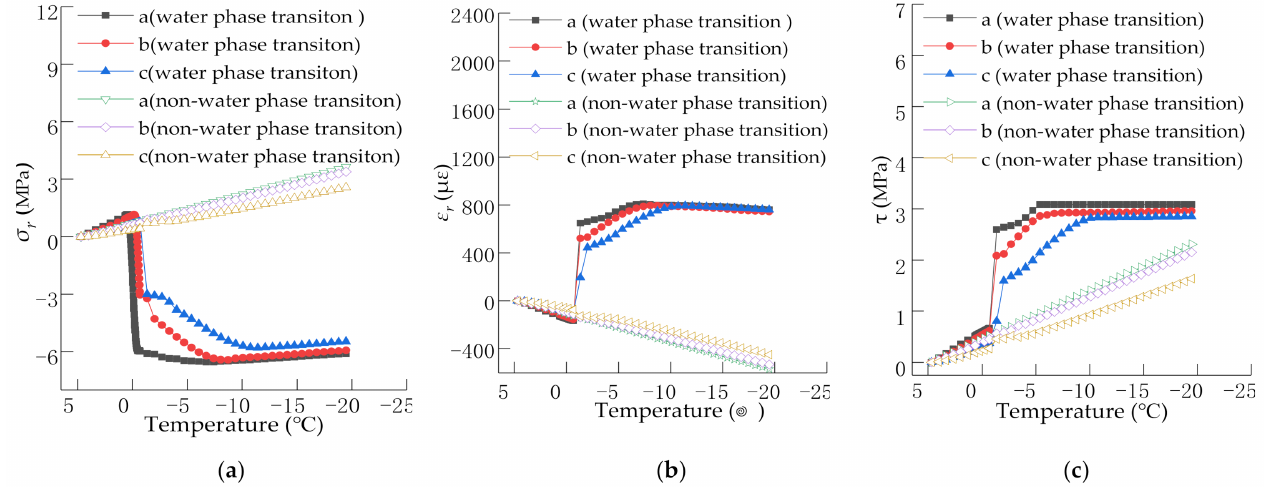
Figure 4. Varying characteristics of stress and strain with temperature, where ( a ) is the horizontal stress, ( b ) is the horizontal strain, and ( c ) is the shear